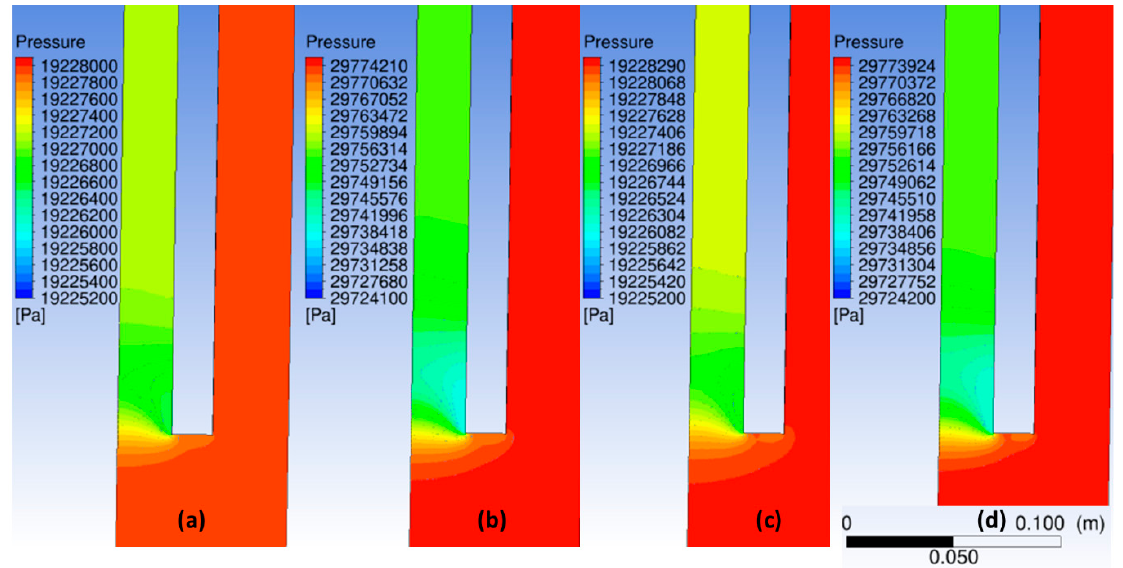
Figure 7. CFD study. Static pressure distribution at the bottom of the internal tubing for a mass flow rate injection with constant water properties of 2 kg/s ( a ) and 10 kg/s ( b ) and with the IAPWS-IF97 properties for 2 kg/s ( c ) and 10 kg/s ( d ).